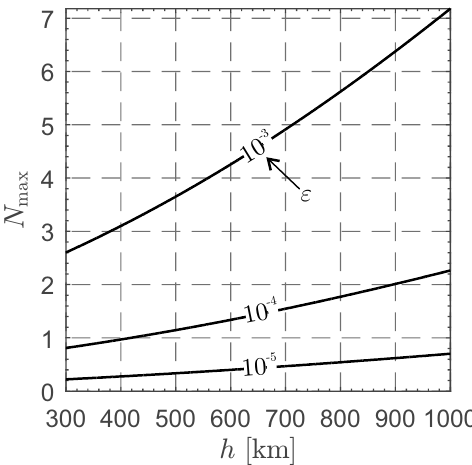
Figure 4. Variation of N max with h and (cid:101) when a T 0 = 0.0024mm/s 2 and h 0 =